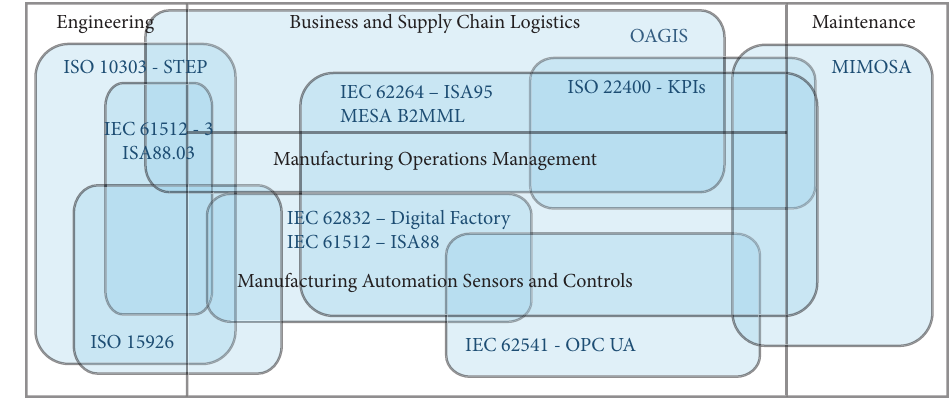
Figure 3: A summary of international standards for smart manufacturing